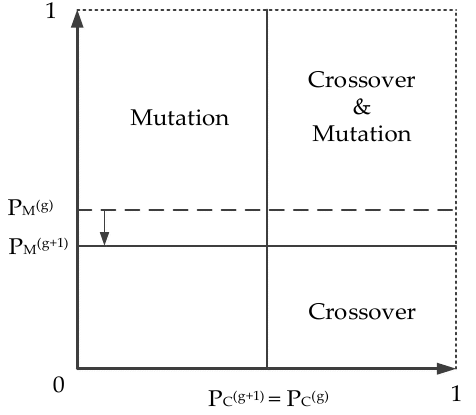
Figure 7. Variation for increasing mutation probability.